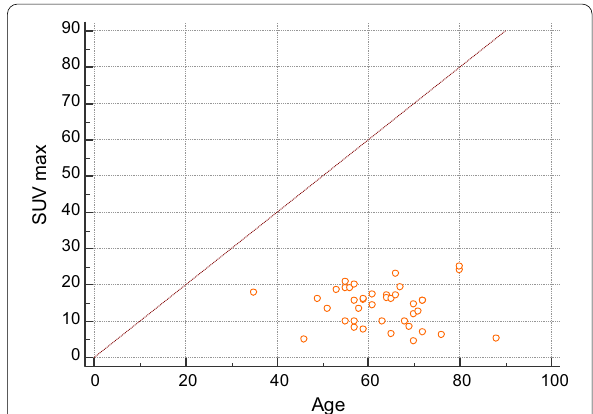
Fig. 6 Scatter diagram displaying insignificant correlation between tumor max.SUV and the age of